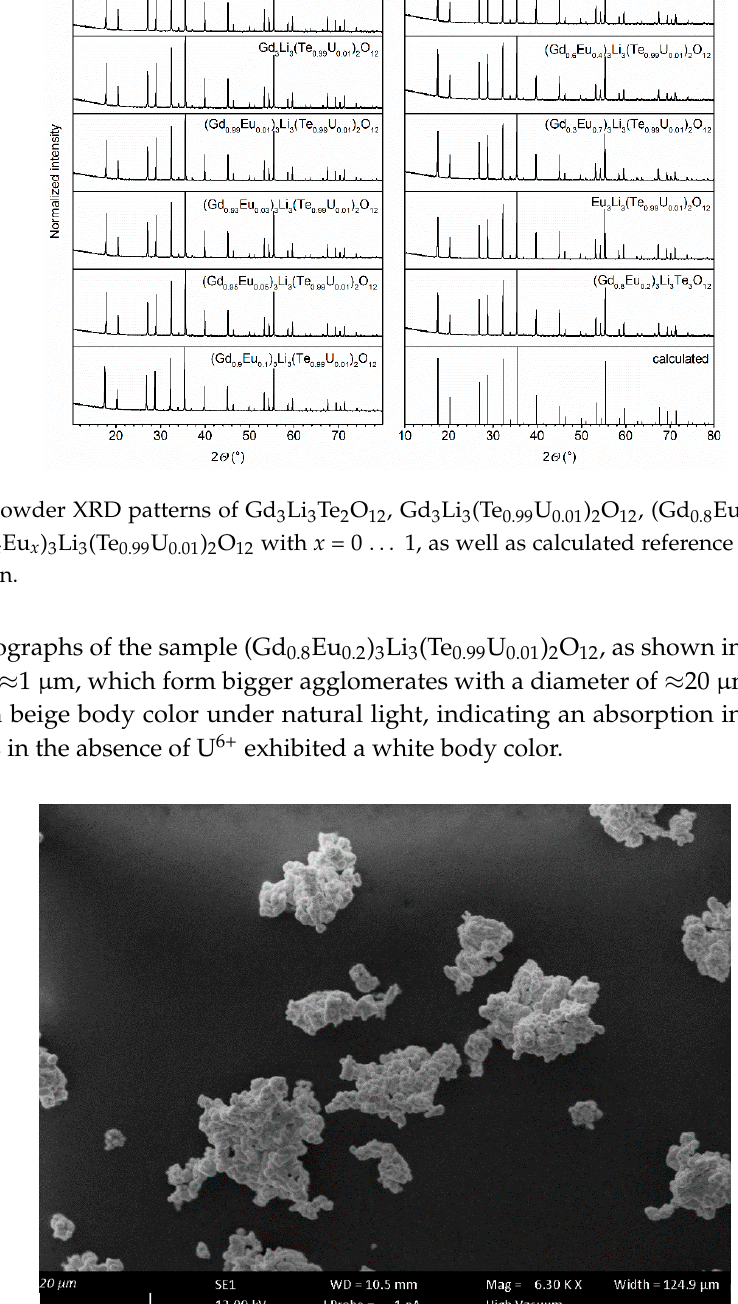
Figure 5. Scanning electron micrograph of (Gd 0.8 Eu 0.2 ) 3 Li 3 (Te 0.99 U 0.01 ) 2 O 12 particles.